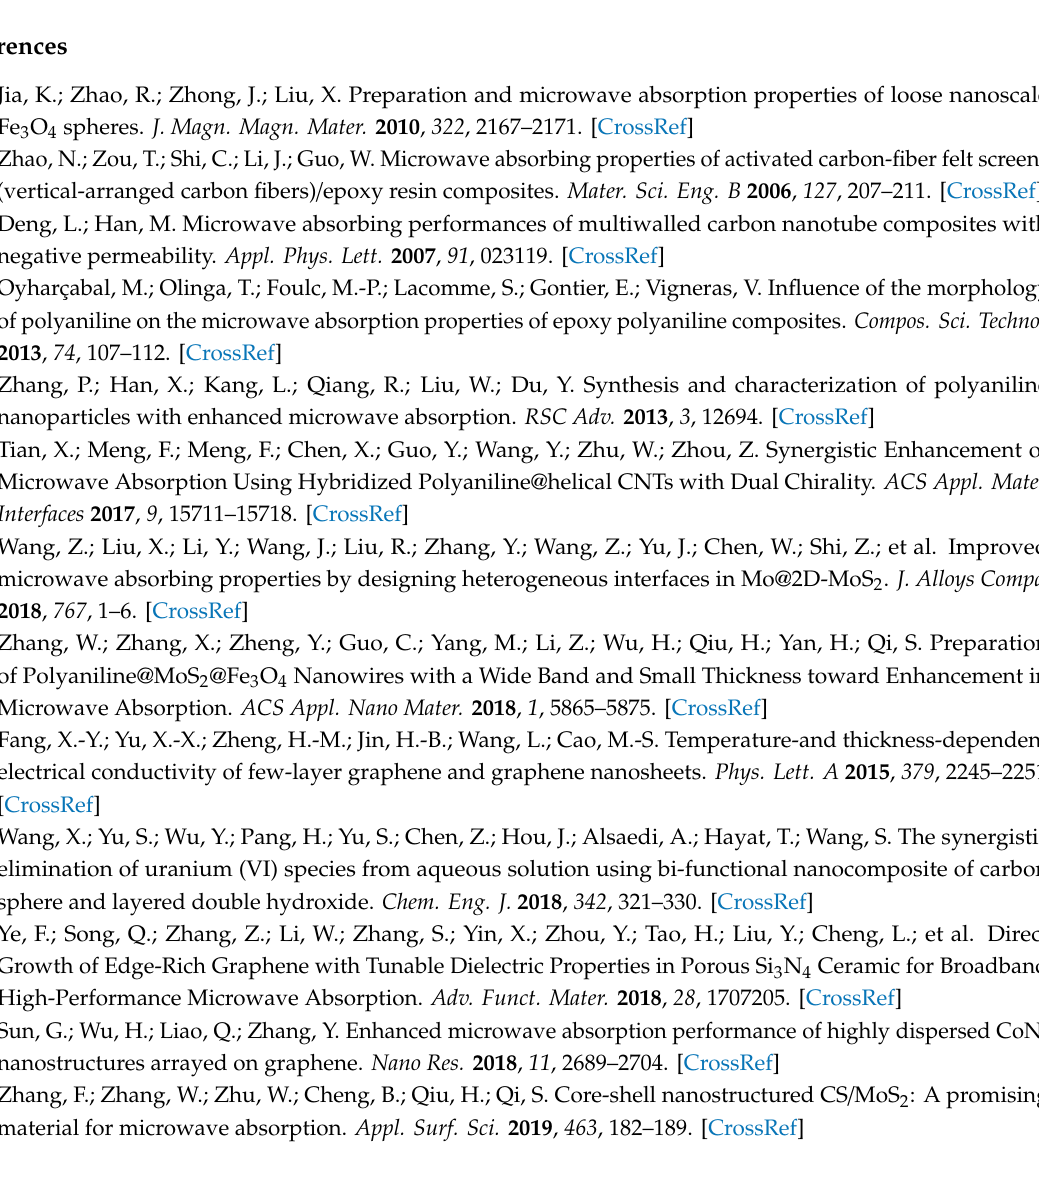
Figure S1: Electromagnetic parameters (a,b), tangent of dielectric loss (c) and α (d) of of GNPs and GNPs@Ni composite., Figure S2: RL and corresponding 3D plots of GNPs (a,b) and GNPs@Ni composite (c,d), Figure S3: Z and RL contour maps of GNPs (a,b) and GNPs@Ni composite (c,d), Table S1: the composition of as-prepared composites, Table S2: Conductivity of as-prepared GNPs, GNPs@Ni and GNPs@Ni x S y @MoS 2